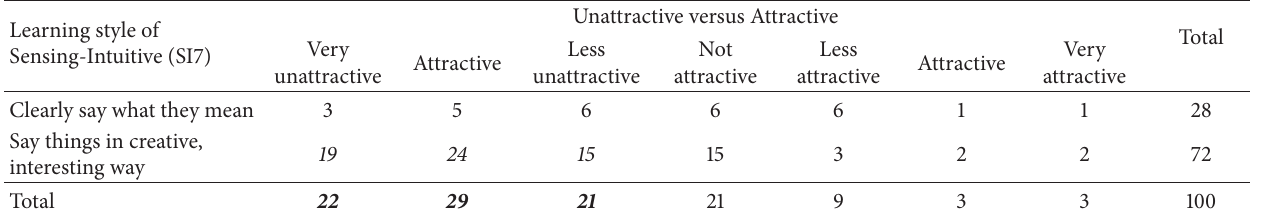
Table 17: The interpretation of Design no. 2 versus the students preferences in enjoyment of reading the book